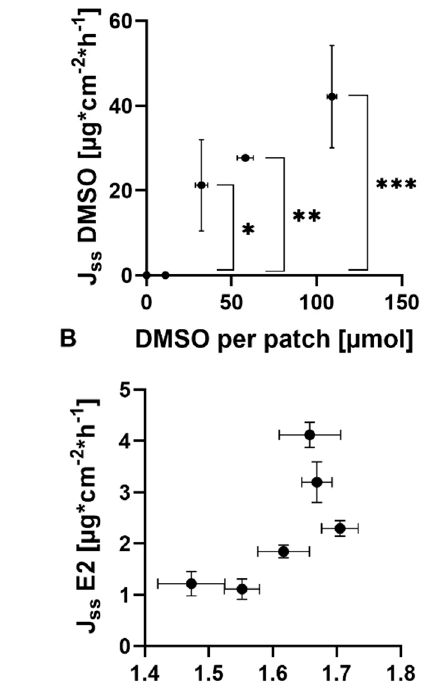
Figure 4. Permeation profiles of E2 ( A ) and DMSO ( B ) across pig skin at 32 °C. Percental permeated amount of DMSO: 35 °C, 4 h: 11.5 ± 0.7; 40 °C, 2 h: 21.8 ± 1.9; 35 °C, 3 h: 65.4 ± 3.1 (mean ± SD). *** Indicates significant differences ( p < 0.001).